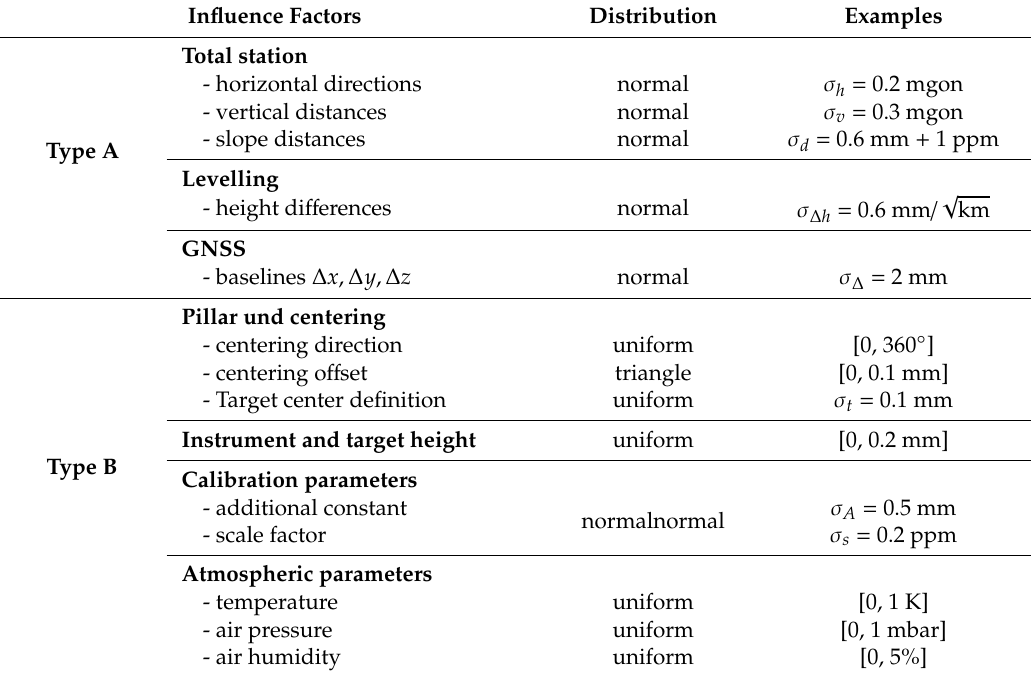
Table 1. Type A and Type B influencing factors, possible probability distribution functions and variability range for typical geodetic observations, taken from